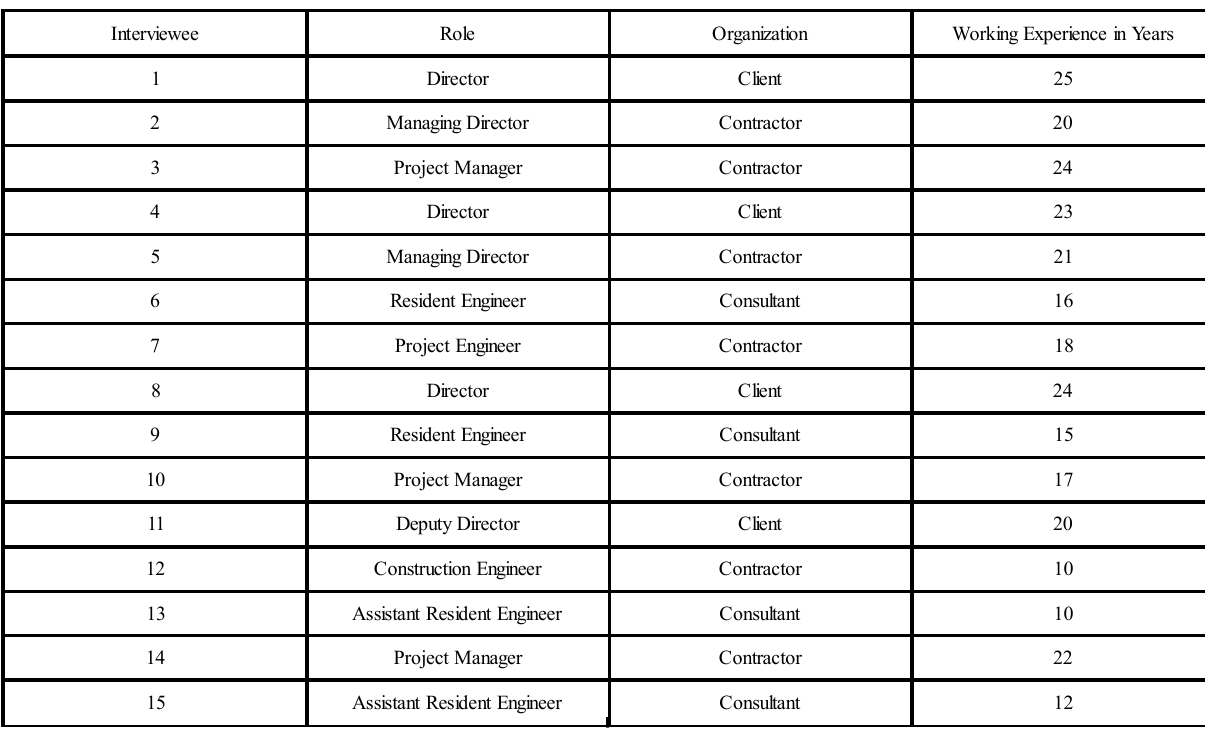
TABLE 3. DEMOGRAPHY OF